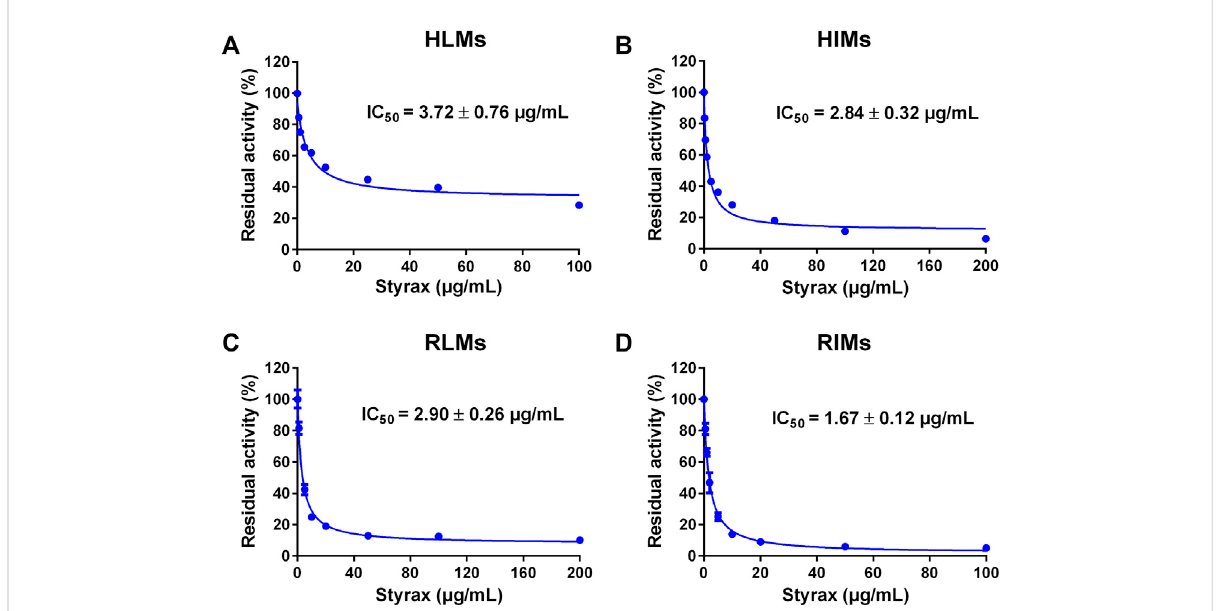
FIGURE 2 (A) Dose-inhibition curve of Styrax extract towards midazolam 1 ′ -hydroxylation in HLMs. (B) Dose-inhibition curve of Styrax extract towards midazolam 1 ′ -hydroxylation in HIMs. (C) Dose-inhibition curve of Styrax extract towards midazolam 1 ′ -hydroxylation in RLMs. (D) Dose-inhibition curve of Styrax extract towards midazolam 1 ′ -hydroxylation in RIMs. Data are expressed as mean ± SD.